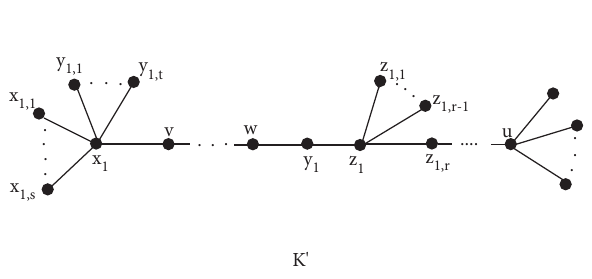
Figure 3: τ − transform applied to K 3